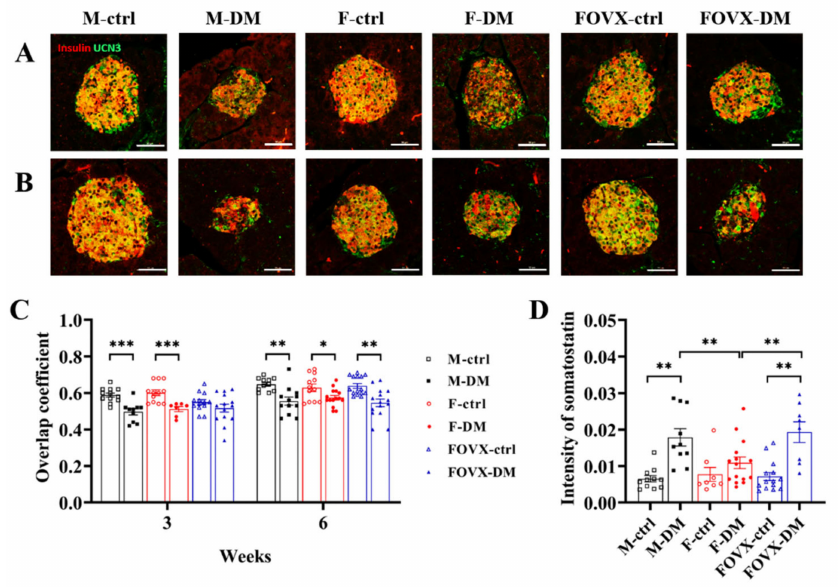
Figure 6. Differences in the expression of UCN3 and somatostatin between diabetic and control groups. To detect the expression of UCN3, immunofluorescence staining was performed at weeks 3 ( A ) and 6 ( B ). The overlap coefficient of UCN3 and insulin ( C ) was evaluated. The intensity of somatostatin ( D ) was measured at week 6. The cells expressing both UCN3 and insulin were significantly reduced in the diabetic groups compared with the control groups at week 6. The overlap coefficient indicates the association between the two distributions by the regions where the expression of the two markers (insulin, UCN3) overlap. Data were analyzed using an independent two-sample t -test. * p < 0.05, ** p < 0.01, *** p < 0.001 compared with the respective control